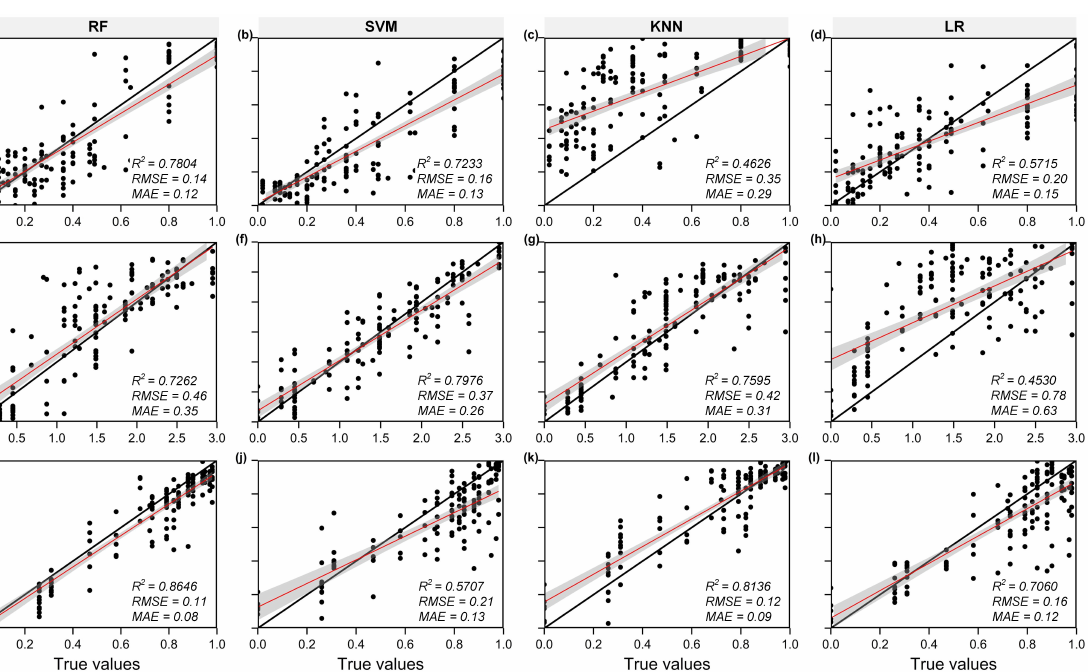
Figure 4. Predicted maps and pixel statistics of forest diversity by the three indices ( a ) λ index, ( b ) H ′ index, ( c ) J ′ index using the RF model.